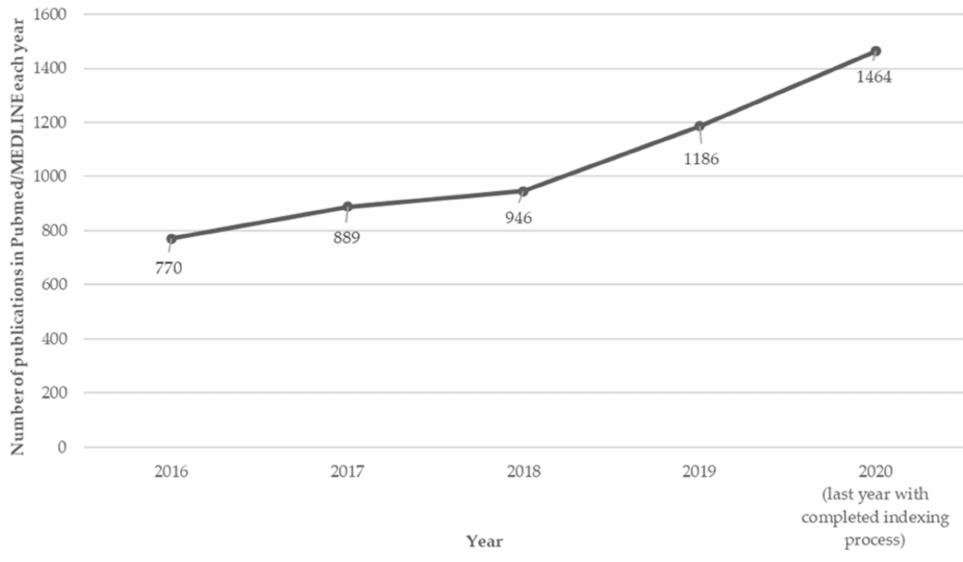
Figure 1. Self-elaborated graph of trends by year of publication for search terms “health AND web-based intervention” from PubMed/MEDLINE data on 26 August